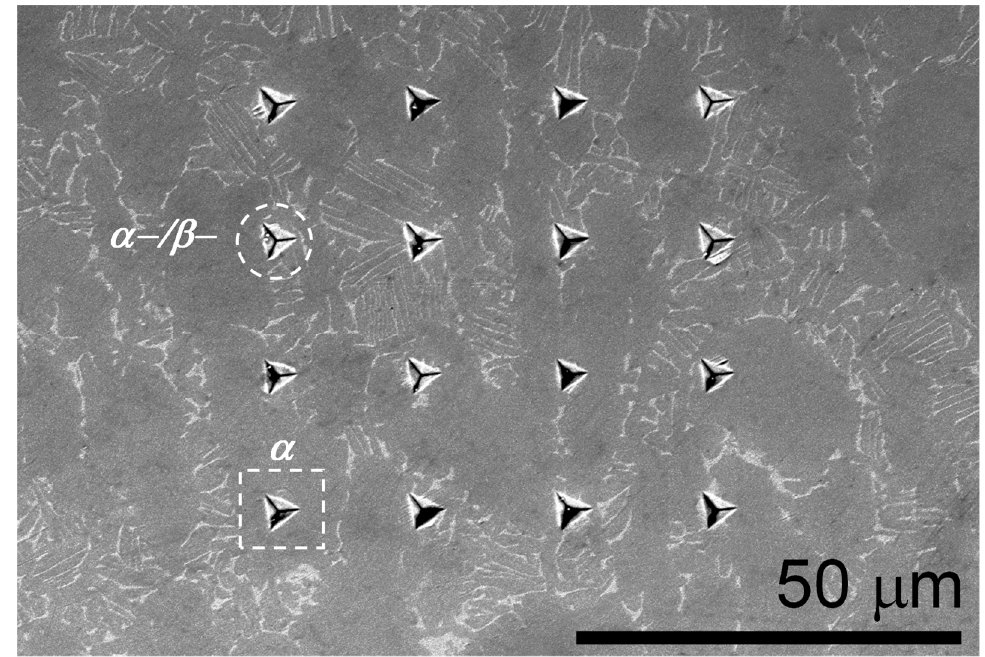
Figure 9. SEM micrograph of one array of imprints performed under the displacement control mode at 700 nm of maximum penetration depth. The white dashed circle denotes an example of a residual imprint performed at the α -/ β -inter- phase.